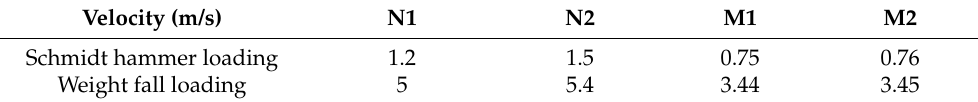
Table 5. The velocity above the coal roadway under Schmidt hammer loading and weight fall loading. Velocity (m/s)